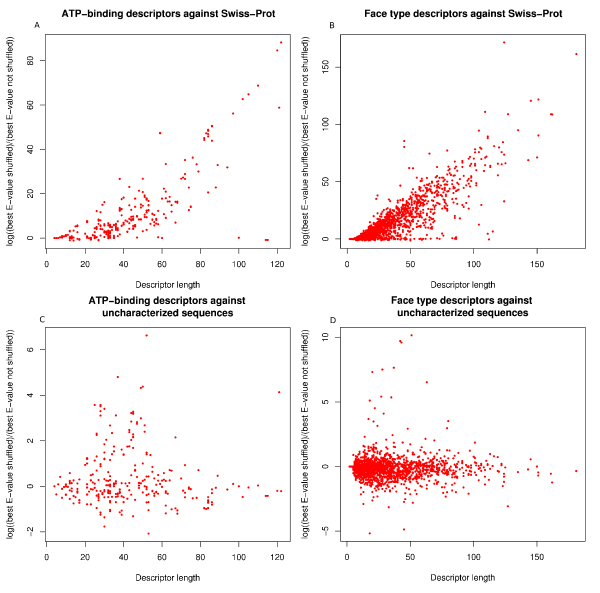
Correlation of length and quality of HMM descriptors. ATP-binding descriptors as well as face type descriptors for protein-protein interactions were run against original and shuffled versions of Swiss-Prot and uncharacterized NCBI sequences. We define the length of a profile Hidden Markov Model descriptor as its number of states. Quality is measured as difference between log E-values of best hit against original sequences and shuffled sequences. For Swiss-Prot, longer descriptors have better quality and therefore produce more significant hits. For uncharacterized sequences, this does not hold. One explanation could be that these sequences are depleted of significant matches by similarity searches.